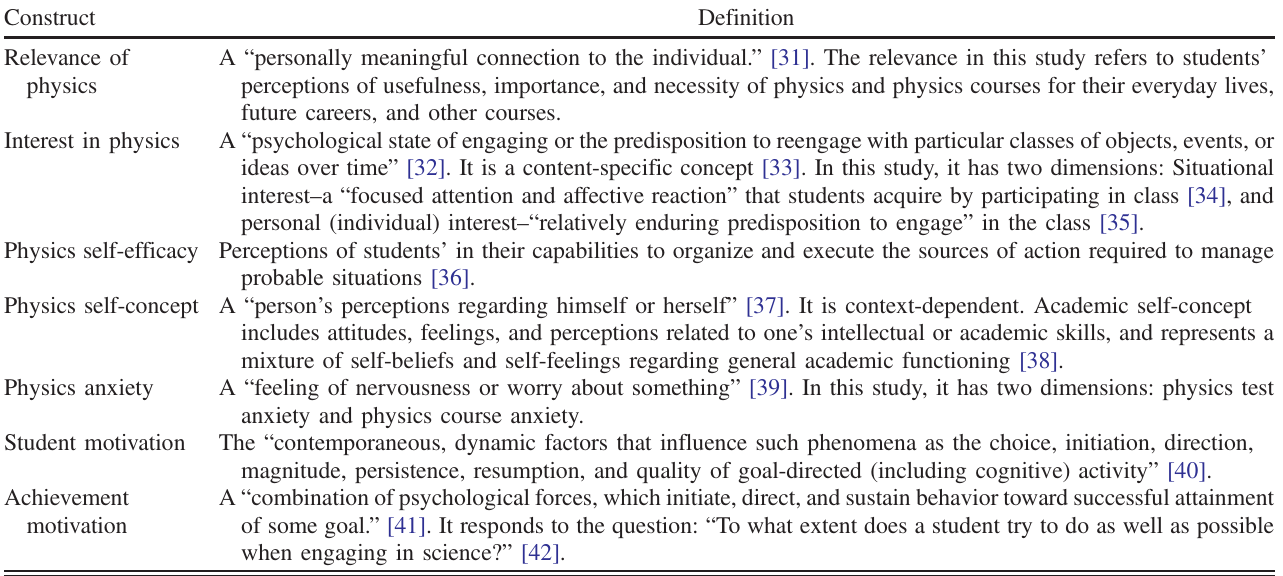
TABLE I. Definition of the constructs of the